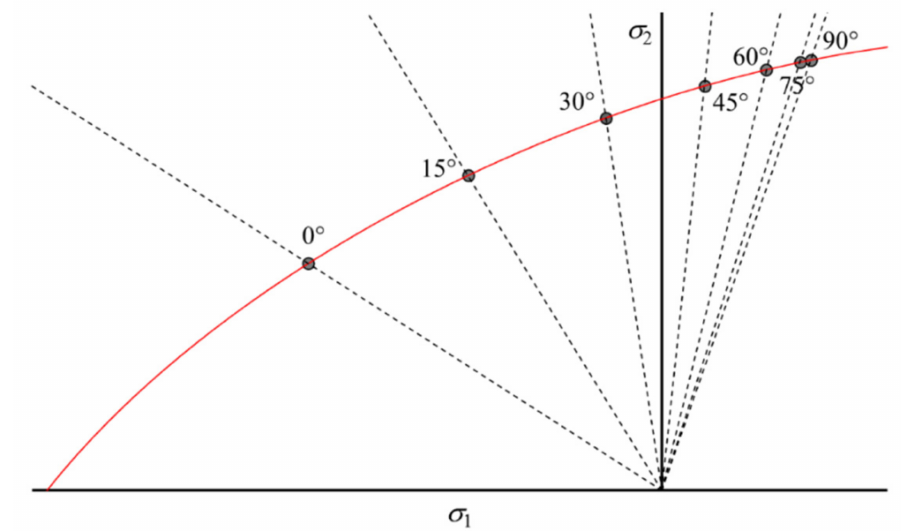
Figure 3. Resulting principal stress combinations for the orientation of the Arcan